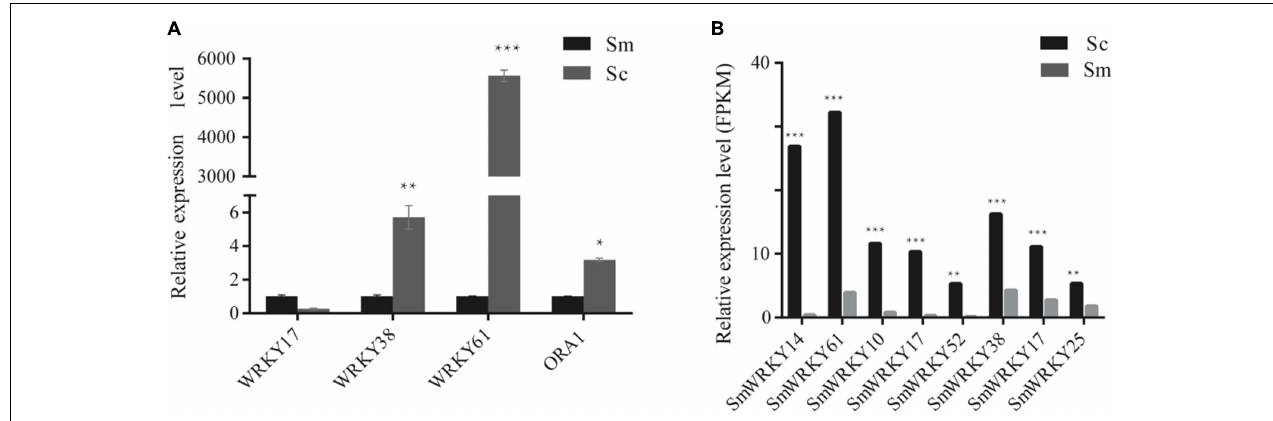
FIGURE 3 | Relative expression level of WRKYs in S. miltiorrhiza and S. castanea. (A) RT-QPCR levels of WRKY transcription factors in hairy roots of S. miltiorrhiza and S. castanea. (B) Expression level of WRKY ( S. castanea / S. miltiorrhiza ) in S. miltiorrhiza and S. castanea transcriptomes. “*” represents 0.01 < P < 0.05, “**” represents P < 0.01, “***” represents P <